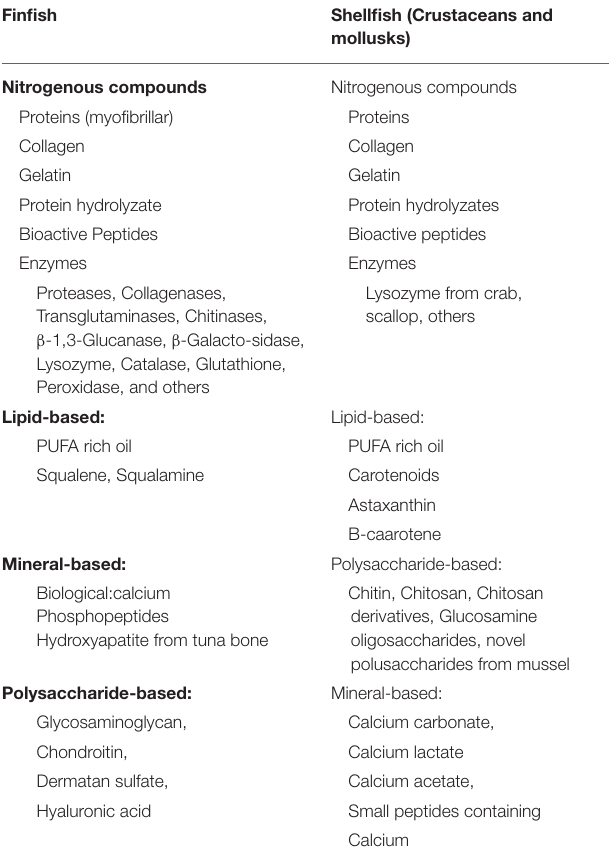
TABLE 2 | Major seafood-derived industrial components and